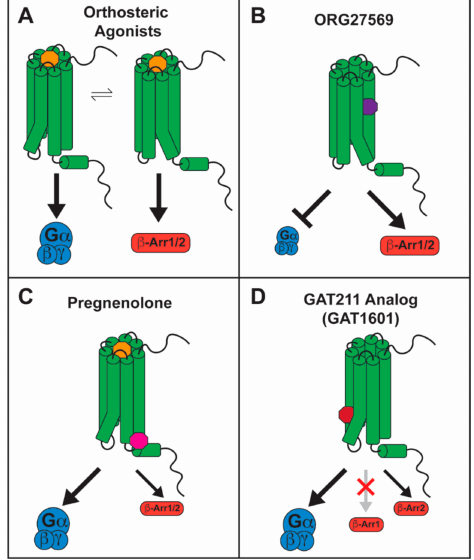
Figure 3. Biased signaling by CB1 allosteric ligands: ( A ) orthosteric ligands, represented in yellow, promote G-protein signaling and β -arrestin recruitment in a balanced manner, stimulating confor- mational changes important for both; ( B ) ORG27569, in purple, inhibits G-protein signaling and stimulates β -arrestin signaling, whether alone or in the presence of an orthosteric ligand, generating β -arrestin-biased signaling. This occurs due to inhibition of TMH6 movement and stimulation of TMH7/Hx8 movement, respectively; ( C ) pregnenolone, in magenta, inhibits β -arrestin signal- ing in the presence of an orthosteric ligand, generating G-protein-biased signaling. This occurs due to inhibition of TMH7/Hx8 movement while allowing TMH6 movement; ( D ) GAT1601, in dark red, stimulates G-protein signaling and β -arrestin2 recruitment to a smaller extent but not β -arrestin1 recruitment, generating G-protein-biased signaling. This occurs due to the facilitation of TMH6